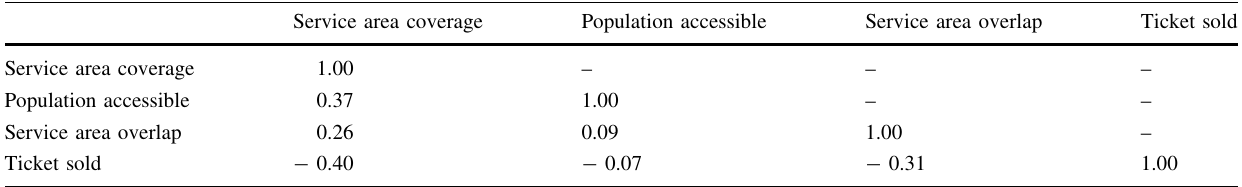
Table 7 Showing matrix of correlation coefficients for 800-m Walking distance Service area